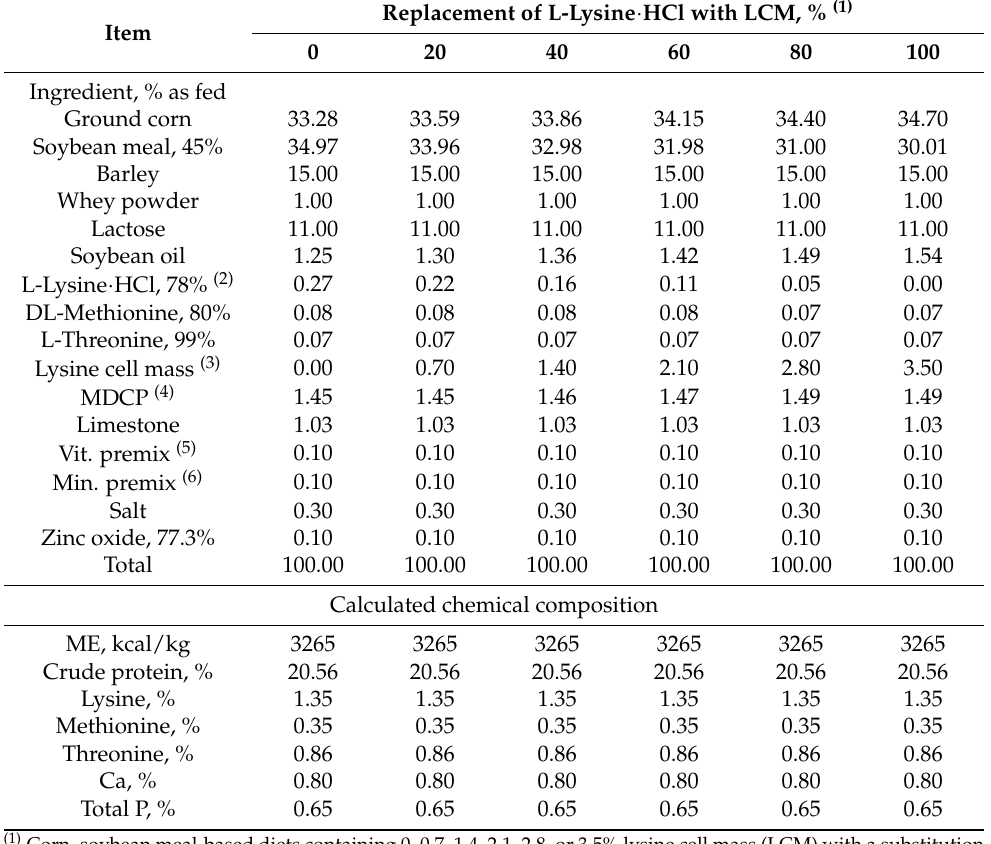
Table 4. The diet formulation and chemical composition of experimental diets for experiment 2 (phase